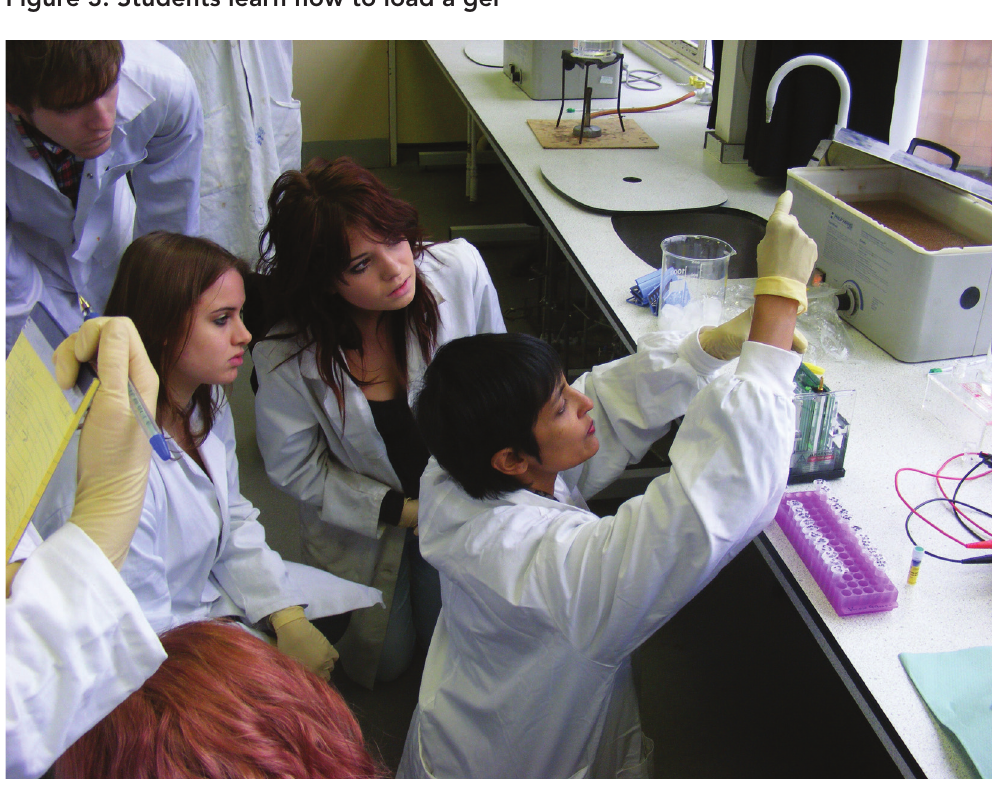
Figure 3: Students learn how to load a gel